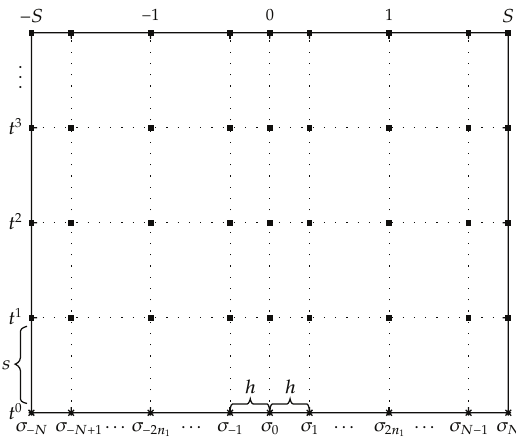
Figure 1: Numerical